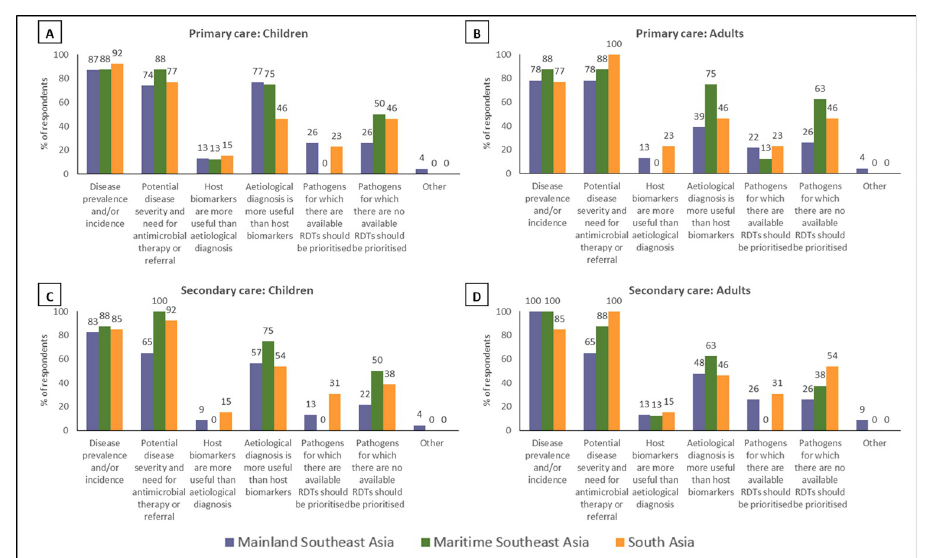
Fig 5. Reasons underlying the rankings made by individual expert participants of analytes which should be prioritized for inclusion in multiplex lateral flow rapid diagnostic tests for acute non-malarial fever using fingerprick blood as the test substrate, in the following patient populations: (A) Children presenting to primary care settings (B) Adults presenting to primary care settings (C) Children being admitted to secondary care settings (D) Adults being admitted to secondary care settings. Children were defined as patients aged > 28 days and < 15